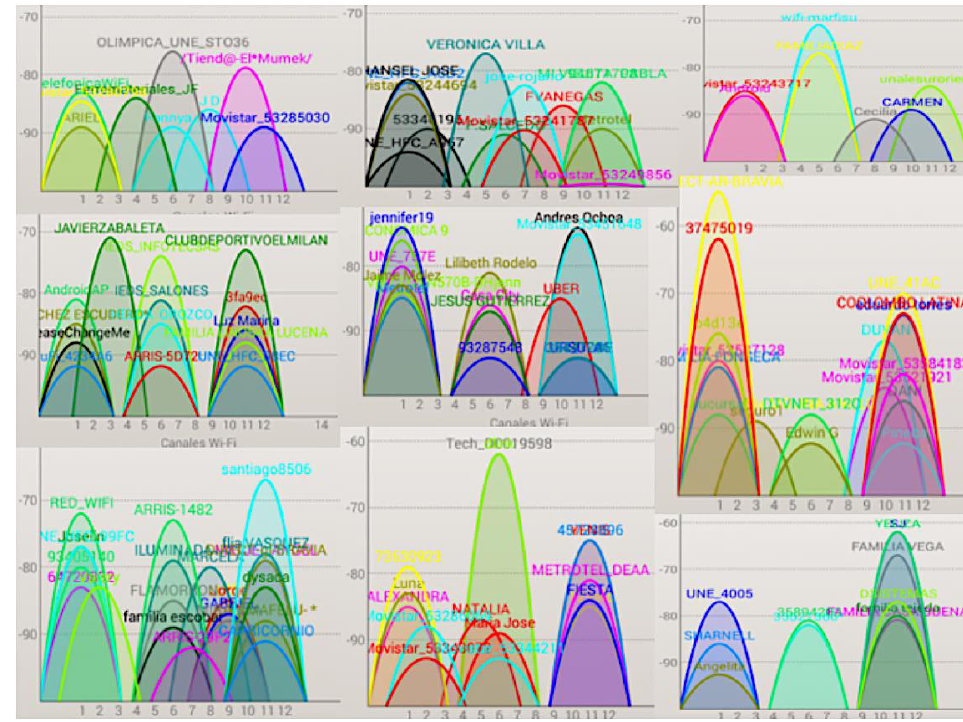
Figure 3. Presence of WiFi signal in urban environment.